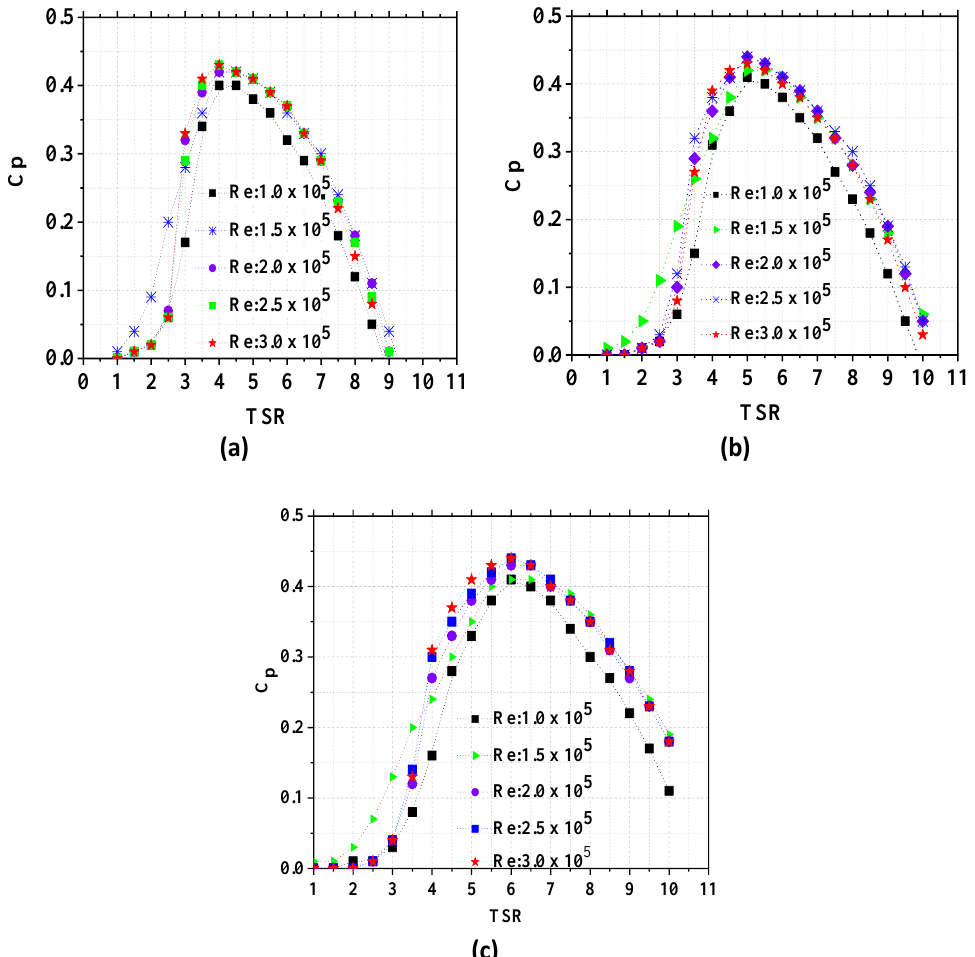
Figure 14. Power coefficients obtained with NACA 4412 rotor blades for ( a ) TSR 4 ( b ) TSR (5) ( c ) TSR 6.